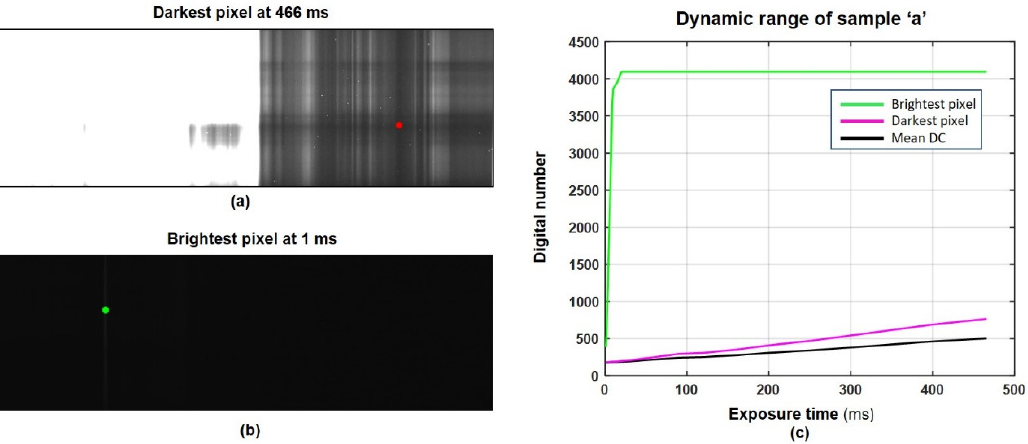
Figure 7. Spectral reflection at minimum and maximum exposure times of sample ‘a’: ( a ) darkest pixel in the image at 466 ms exposure time, ( b ) brightest pixel in the image at 1 ms exposure time, ( c ) raw values of the brightest and darkest pixel, and mean DC values in sample images at different exposure times.